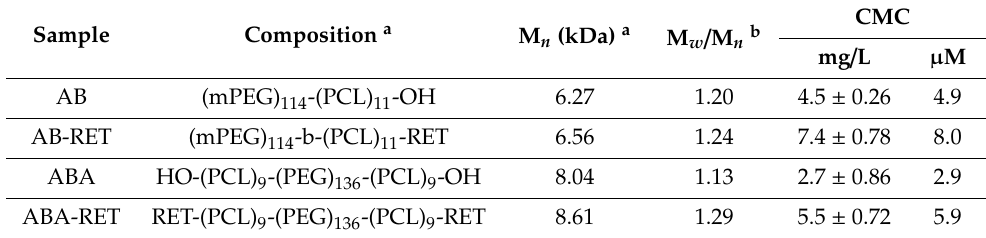
Table 1. Characterization of mPEG-b-PCL (AB) and PLC-b-PEG-b-PCL (ABA) and their corresponding conjugated structures.